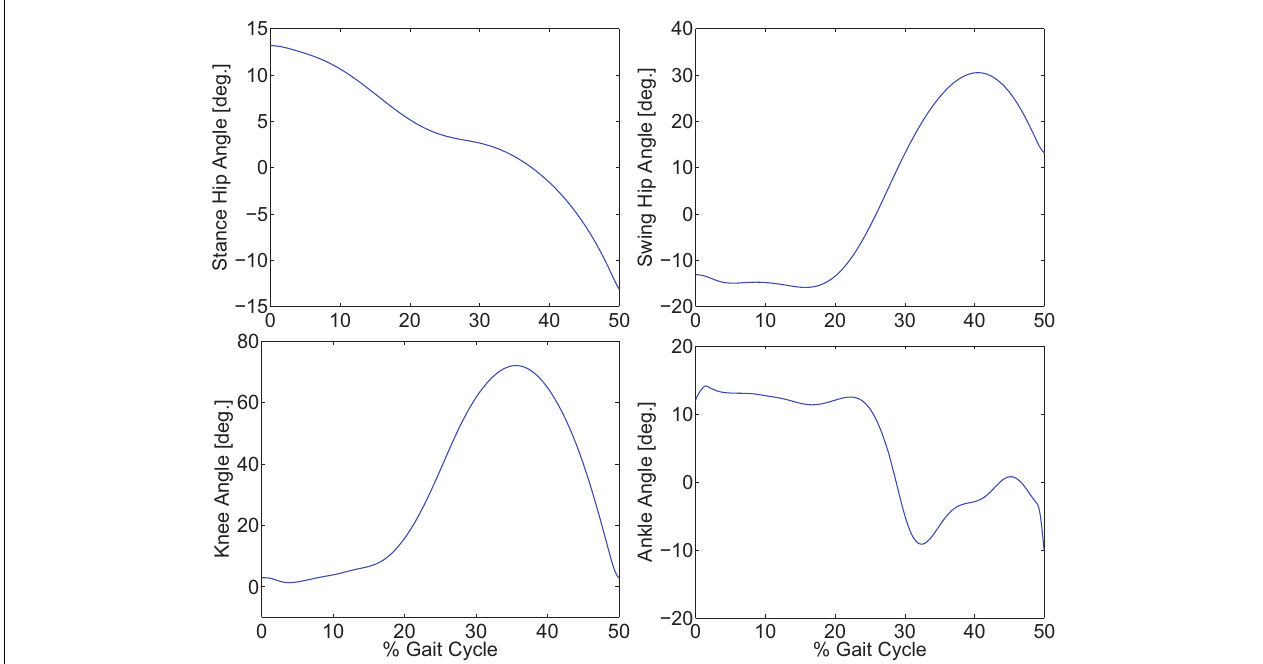
FIGURE 2 | Optimal gait trajectories for a step size of 0.4m in 0.75s